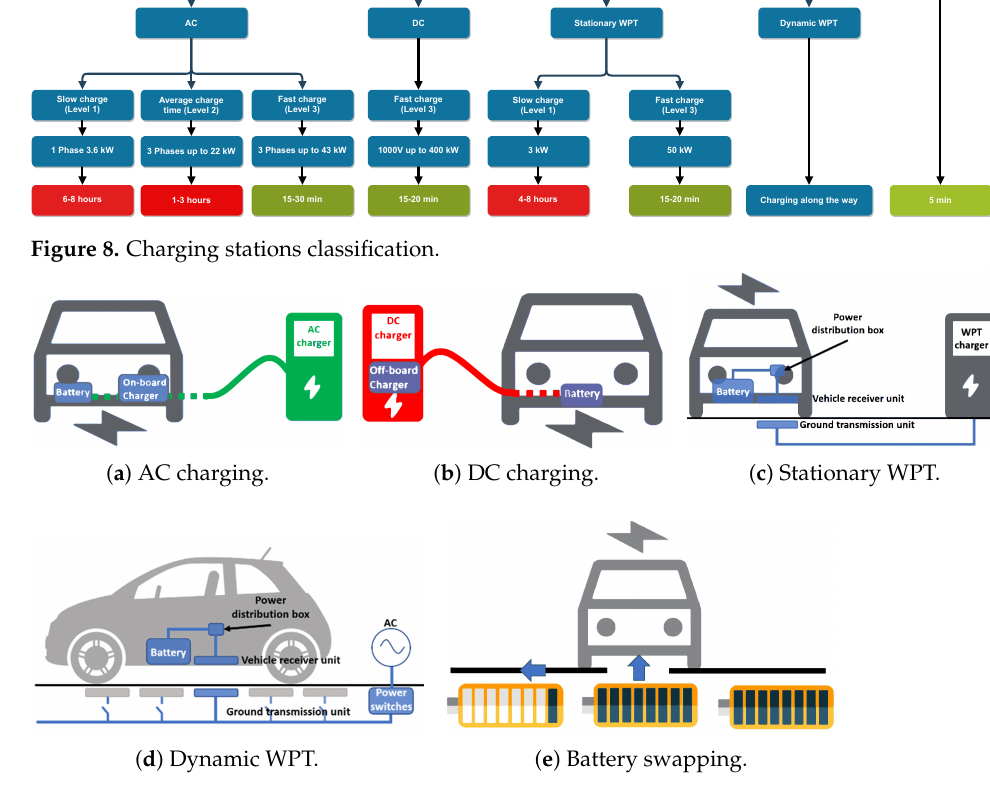
Figure 9. Charging stations classification